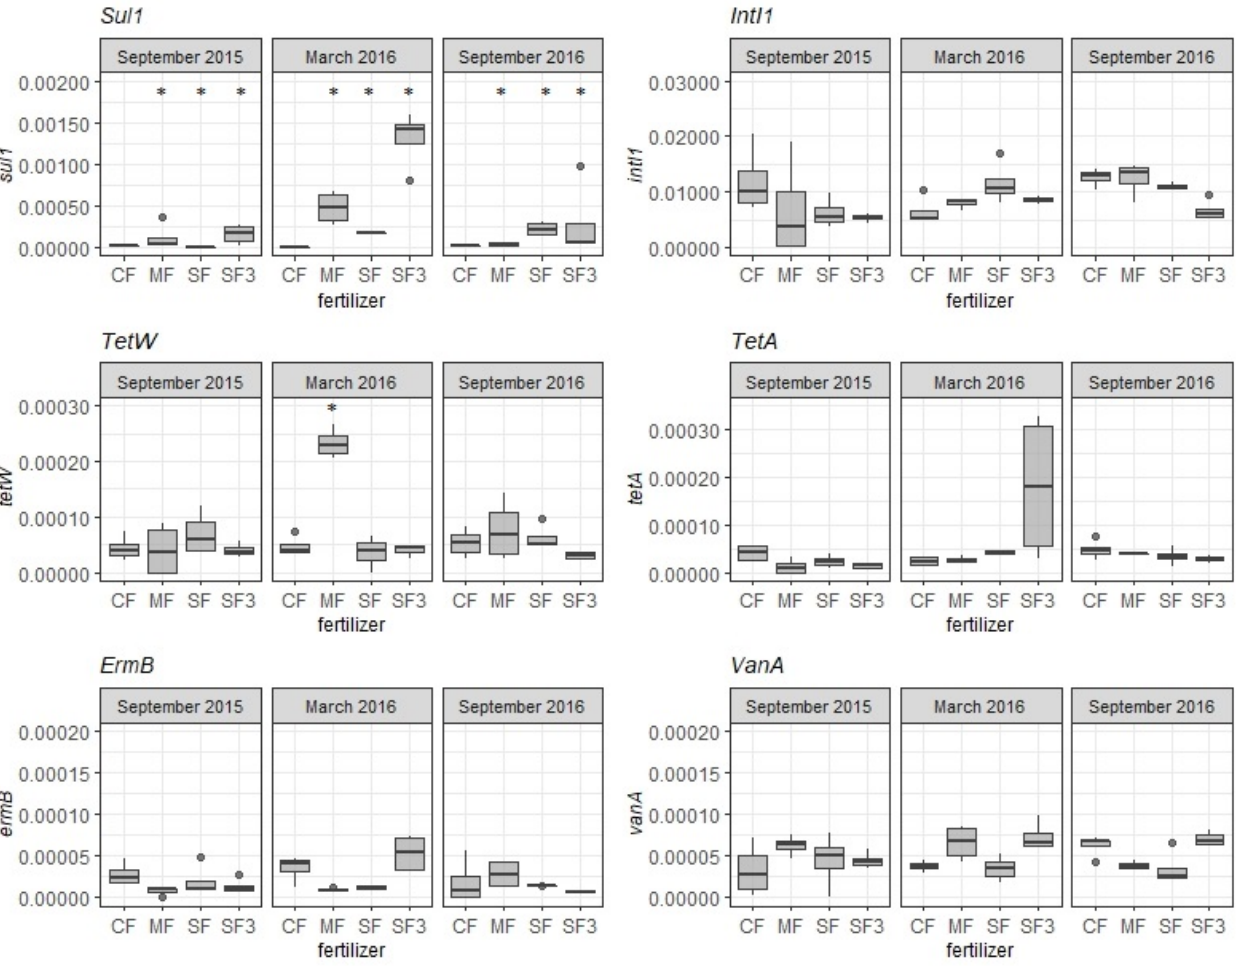
Figure 2. The relative abundance of ARGs and integron Int1 in soils collected over 1 year. When there is a significant difference ( p fdr < 0.05) in relative abundance of ARGs in amended soil versus control soil, the treatment is marked with asterisk. Fertilization treatments: control soil (CF), manure (MF; 330 kg N/ha), sewage sludge (SF; 330 kg N/ha), sewage sludge (SF3; 990 kg N/ha).